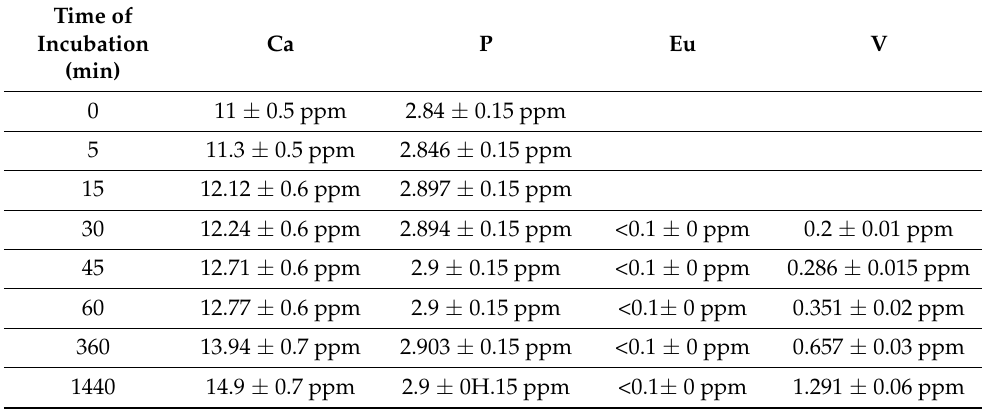
Table 3. The Ca, P, Eu, and V ion release from Ca 9.8 Eu 0,2 (PO 4 ) 5 (VO 4 ) 1 (OH) 2 to the simulated body fluid after 0 min, 5 min, 15 min, 30 min, 45 min, 60 min, 360 min, and 1440 min of incubation with simultaneous